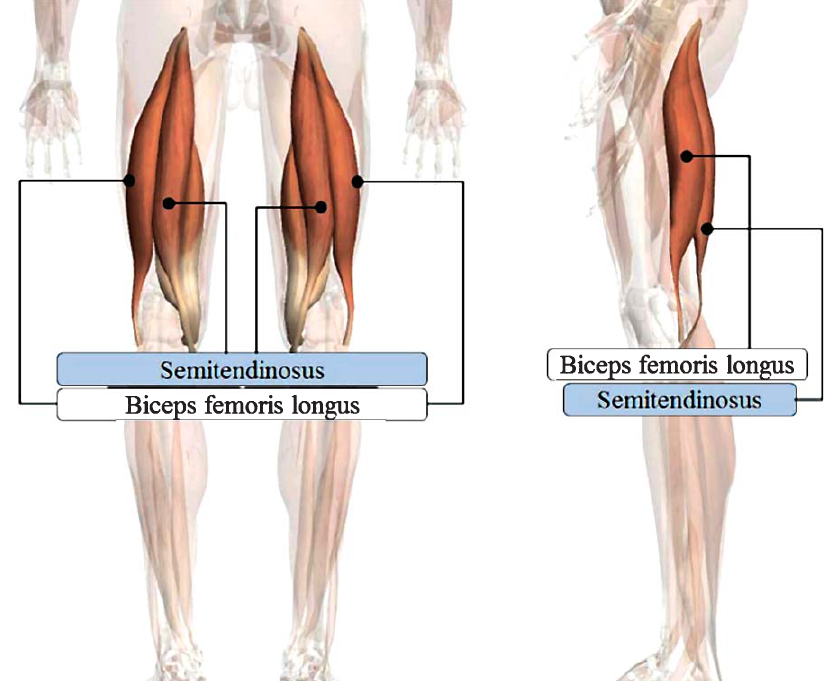
Fig. 2. Two-jointed muscle for hip